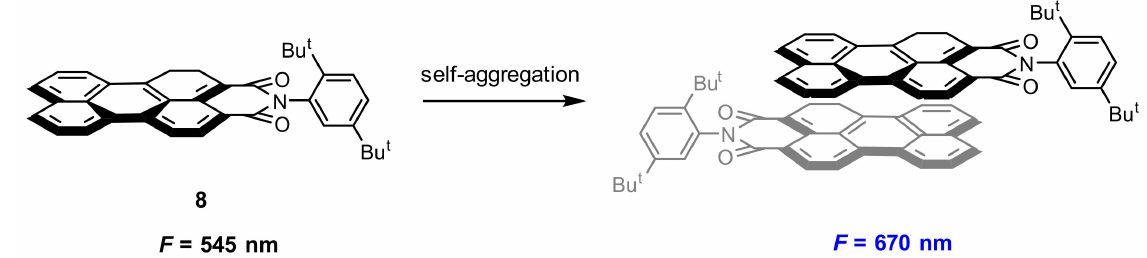
Figure 19. Chemical structure of probe 8 and its